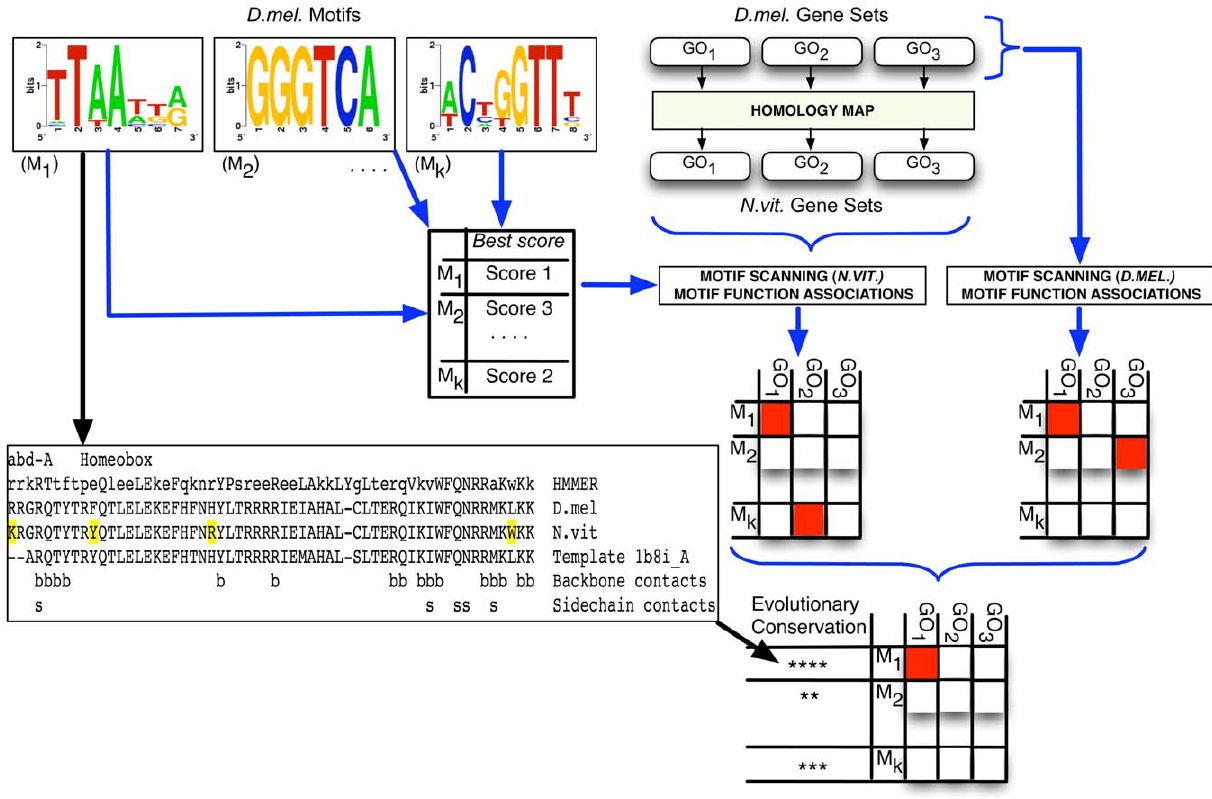
Figure 3. Extended computational pipeline to use information from other species. Motifs and GO annotations were collected from Drosophila (‘‘ D.mel. Motifs’’ and ‘‘ D.mel. Gene Sets’’), and the best motif scanning score for each motif was obtained as described in Figure 1(C). GO annotations in Nasonia (‘‘ N.vit. Gene Sets’’) were obtained from the Drosophila gene sets using a ‘‘homology map’’ for the two genomes. Motif scanning was performed using the selected scores, followed by motif function map construction in each genome separately. Motif – GO associations that were statistically significant in both species were reported, along with information on evolutionary conservation of the motifs. An example of how motif conservation was investigated is shown in the bottom left panel. The homeobox domain of the transcription factor ABD-A was identified in Drosophila and Nasonia using HMMER (row 1), the orthologous domains in the two species were aligned (rows 2 and 3), and a similar domain from the PDB database was added to the alignment (row 4). The positions marked in yellow are where amino acid substitutions were seen, but none of these coincides with positions of DNA-contact (rows 5 and 6) as revealed by the structural template, suggesting that the DNA-binding specificity of ABD-A is conserved (‘‘four stars’’, for MCS=4) between the two